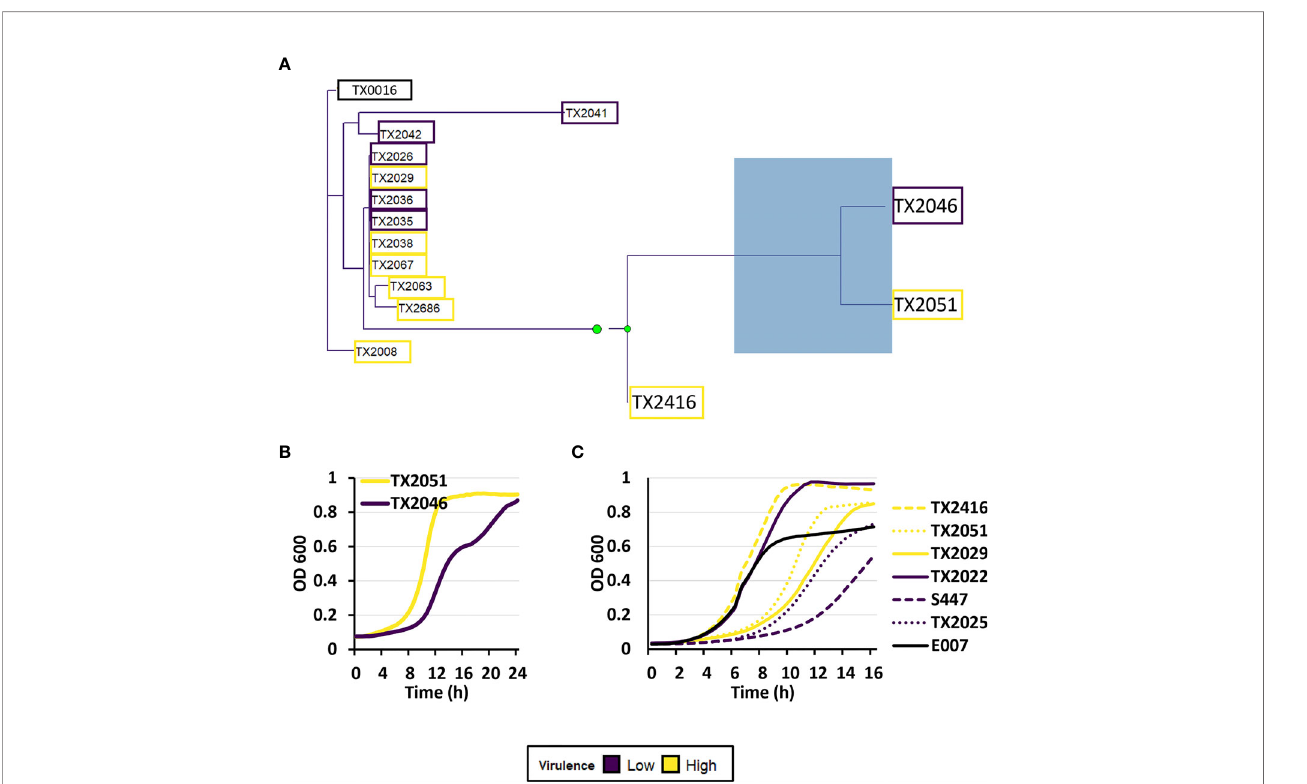
FIGURE 8 | Genomic analysis showed a relationship between high- and low virulence strains. (A) A maximum-likelihood phylogenetic tree of eight strains belonging to the highest virulence group (yellow), six strains belonging to the lowest virulence group (purple), and a reference strain (TX0016, black). The phylogenetic tree was created by performing roary (Galaxy version 3.13.0), followed by RAxML (Galaxy version 1.0.0), and visualized by using treeio (v1.14.3) and ggtree (v2.4.1) packages (RStudio, R version 4.0.3). (B) Kinetic growth measurement or optical densities (OD 600) of TX2046 and TX2051 in BHI media. (C) Kinetic growth measurement